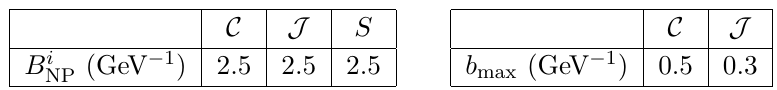
Table 1. Values of non-perturbative parameter B NP and b max prescription chosen for collinear-soft function, heavy meson jet function and dijet soft function. Impact of the varition of B in figure